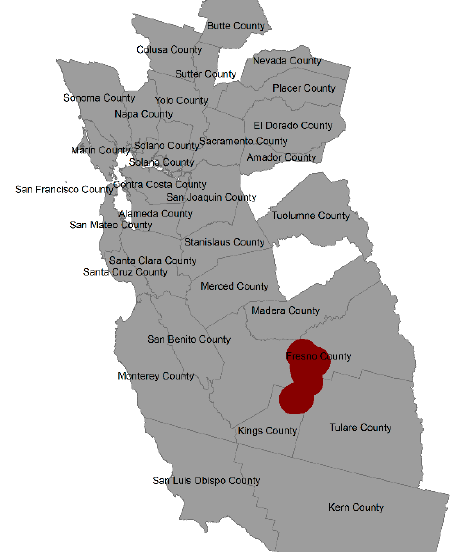
Figure 5. Area of elevated risk in red according to exceedance probabilities of spatial random effects in spatial risk model based on observed data.